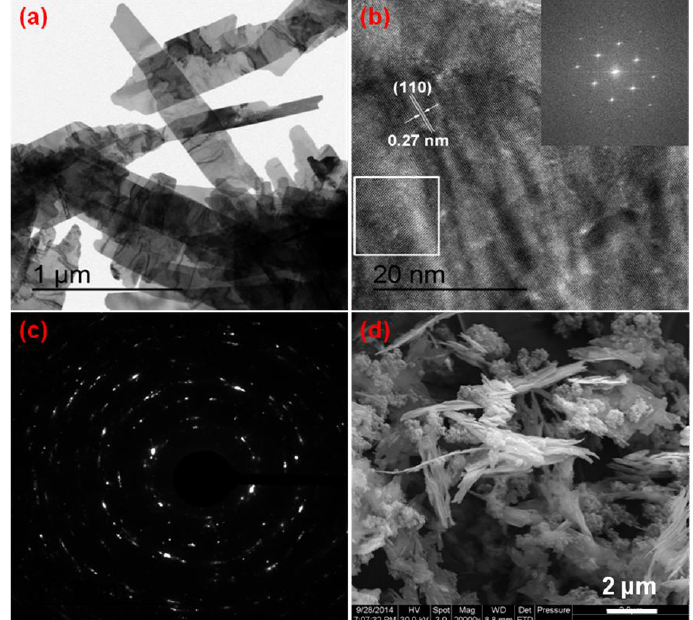
Figure 3. ( a ) Transmission electron microscopy (TEM) image of bamboo leaf-like CuO(b); ( b ) High- resolution transmission electron microscope (HRTEM) image of bamboo leaf-like CuO(b) and the corresponding fast Fourier transform(FFT) pattern (insert); ( c ) Selected area electron diffraction (SAED) pattern of bamboo leaf-like CuO(b); and, ( d ) SEM image of Al/CuO(b) nanothermites.